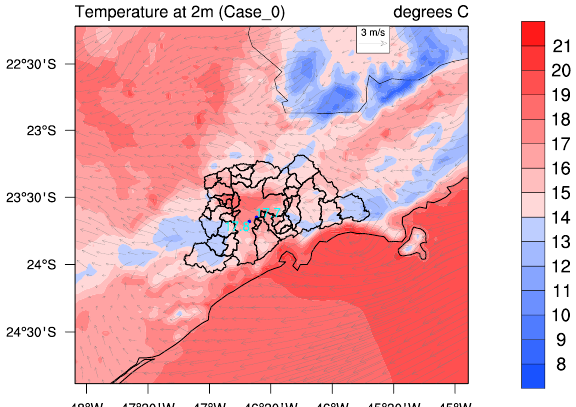
Figure 6. The predicted average of wind vectors at 10m and tem- perature at 2m from the baseline simulation (Case_0) for the whole study period in the 3km modelling domain. Blue dots represent the locations of the measurement sites, whereas cyan numbers represent the observed average temperature in those sites: 17.7 ◦ C in AF-IAG and 17.8 ◦ C in